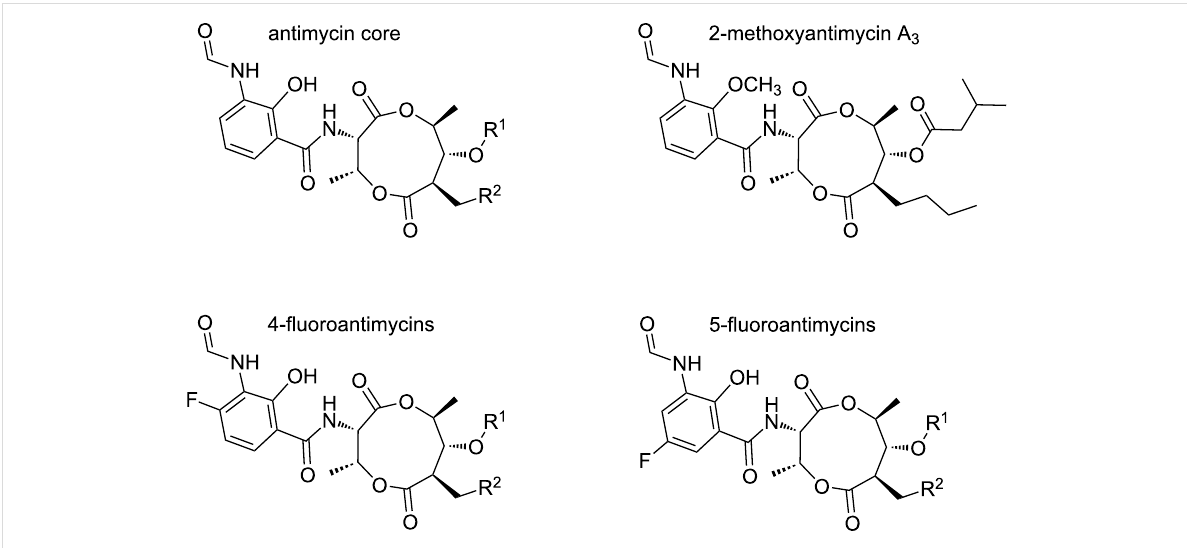
Figure 1: Antimycins: Antimycins A 1 , A 2 , A 3 , and A 4 and non-natural antimycins referenced in the text. Antimycin A 1 , R 1 = COCH(CH 3 )CH 2 CH 3 , R 2 = (CH 2 ) 4 CH 3 ; Antimycin A 2 , R 1 = COCH(CH 3 ) 2 , R 2 = (CH 2 ) 4 CH 3 ; Antimycin A 3 , R 1 = COCH 2 CH(CH 3 ) 2 , R 2 = (CH 2 ) 2 CH 3 ; Antimycin A 4 , R 1 = COCH(CH 3 ) 2 , R 2 = (CH 2 ) 2 CH 3 . For a recent summary of the chemical diversity in the antimycin family see